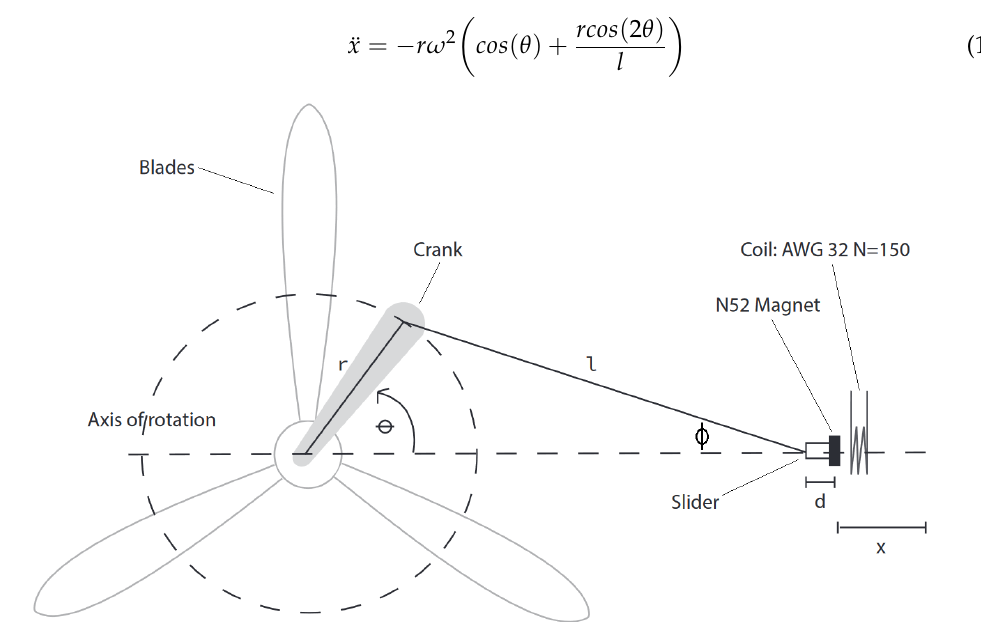
Figure 5. Crank slider mechanism in which the slider is aligned along the axis of rotation for the crank.